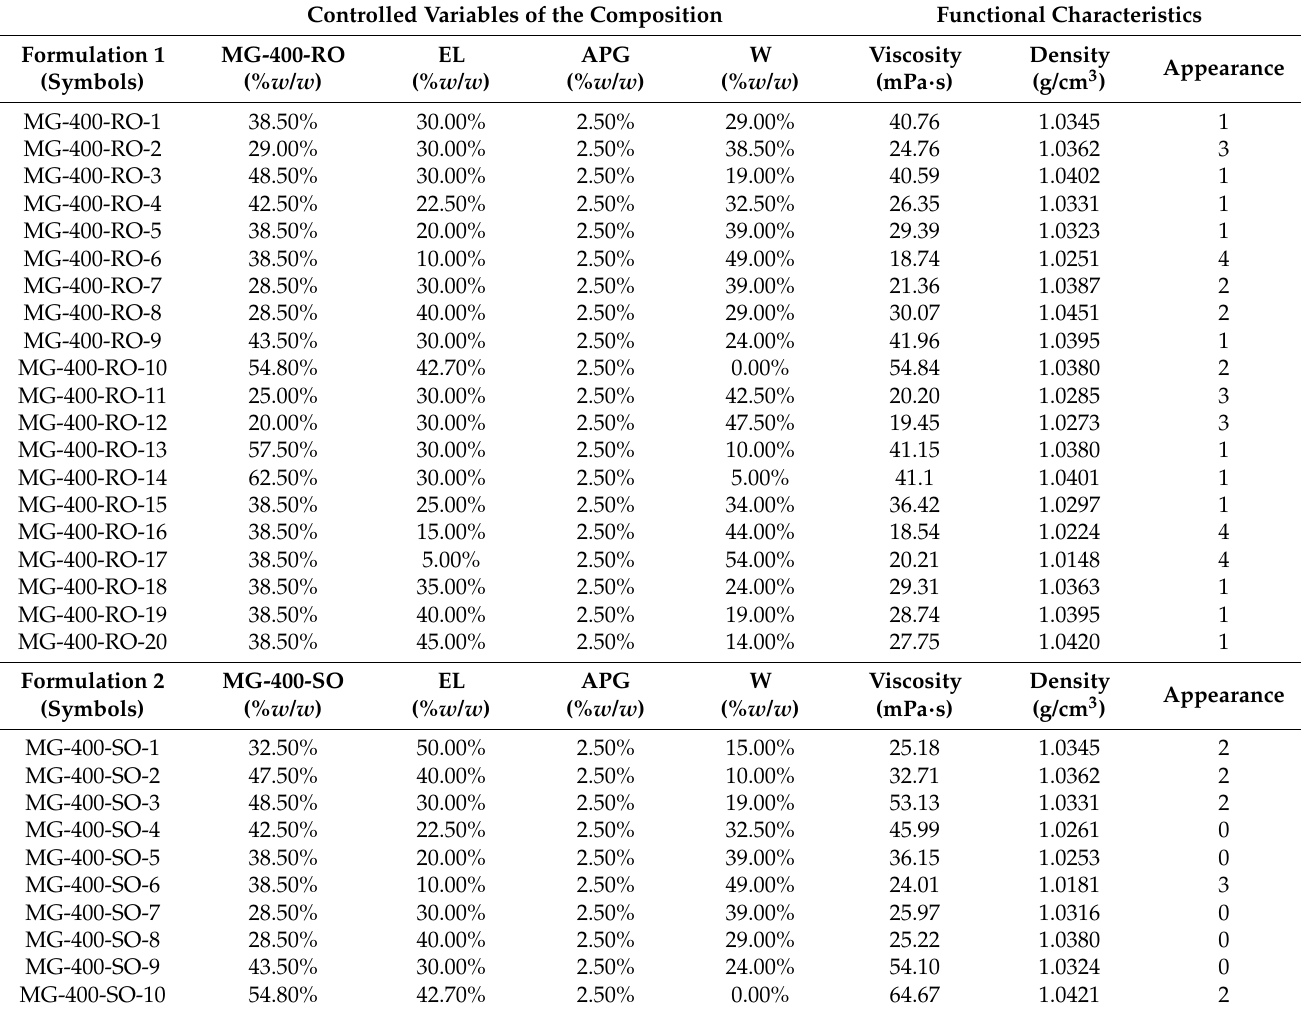
Table 3. The compositions of the eco-friendly graffiti removers and their functional